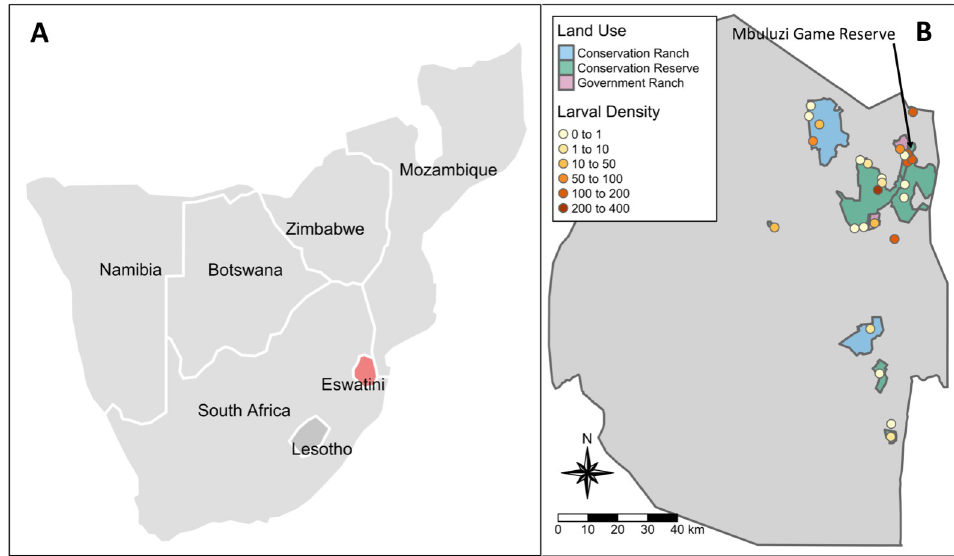
Fig 1. Study area. (A) Map of southern Africa with Eswatini indicated in red and (B) map of Eswatini indicating land use and the density of Amblyomma larvae per 100m 2 at sampling sites during the dry season of 2018. Sampling sites not located within a conservation reserve, cattle ranch, or conservation ranch were in community lands. Made with Natural Earth (https://www.naturalearthdata.com.